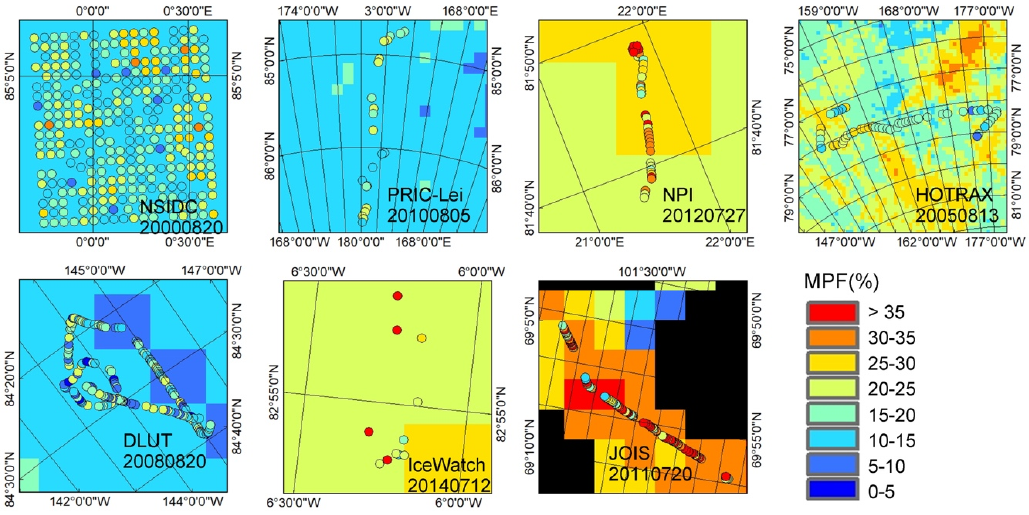
Figure 6. Map-based cases of the observed MPF from multiple sources overlaid on the retrieved MPF.